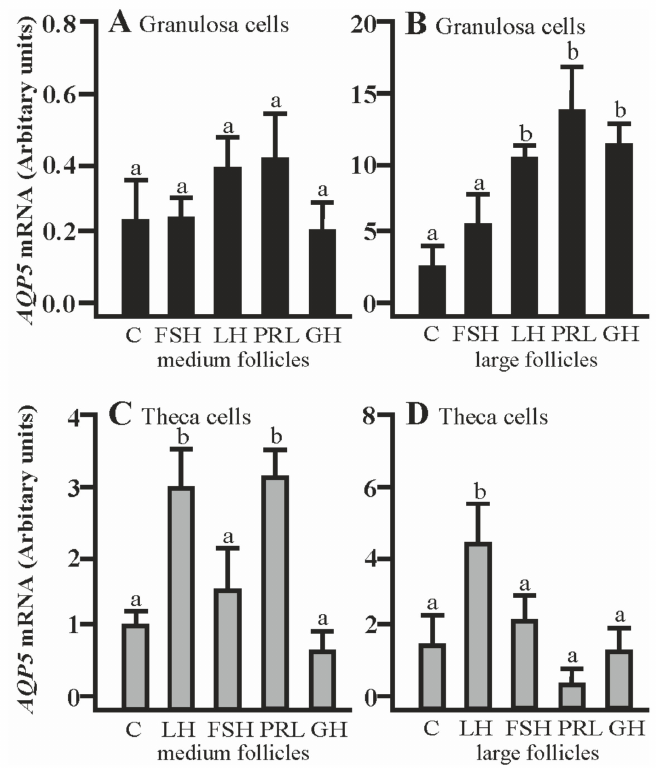
Figure 3. The changes in the expression of AQP5 mRNA in porcine Gc and Tc obtained from MF and LF after 24 h co-culture of these cells in the absence (C) or presence of follicle-stimulating hormone (FSH), luteinizing hormone (LH), prolactin (PRL), and growth hormone (GH). The samples were subjected to real-time qPCR analysis and normalized to the expression of GAPDH and PPIA , ( A , B ) in the Gc and ( C , D ) Tc. Values are expressed as means ± S.E.M from five separate experiments, each performed in triplicate ( p < 0.05 compared with controls). Statistically significant di ff erences between treatments are indicated by di ff erent letters (a,b). C: